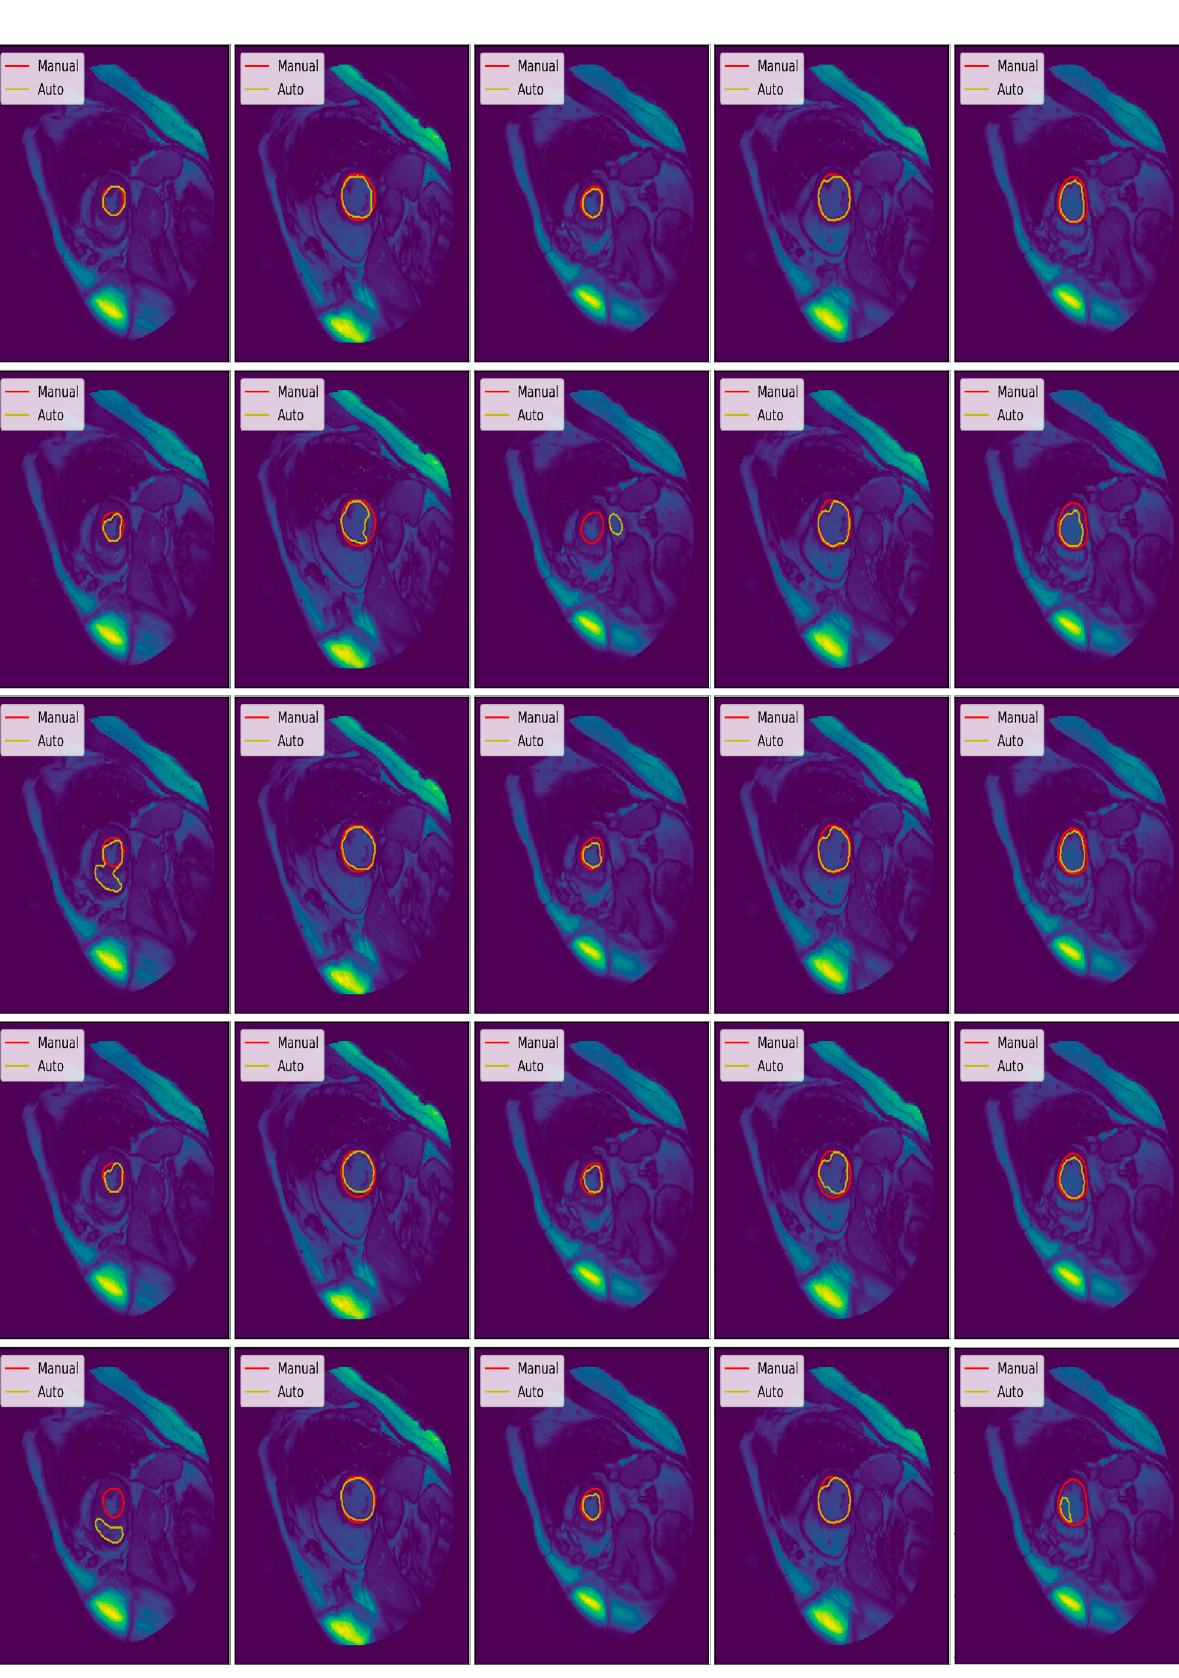
Figure 13. Automatic and manual segmentation results of the endocardium from the validation set of a normal subject (SC-N).